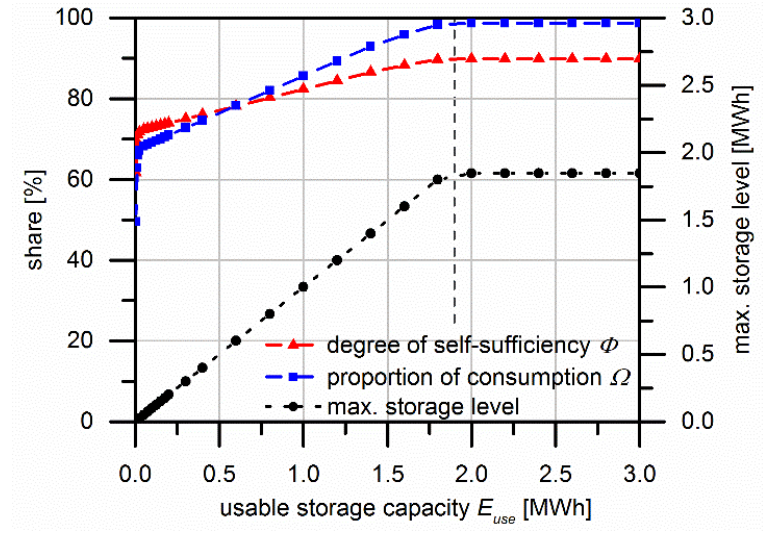
Figure 12. Degree of self-sufficiency and proportion of consumption dependent on usable storage